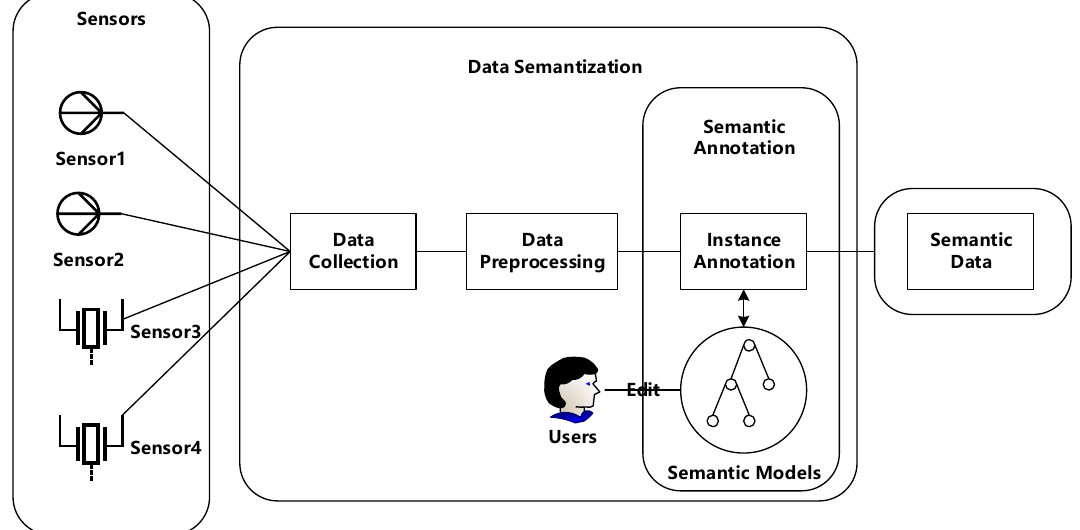
Figure 1. The System Architecture for Adding